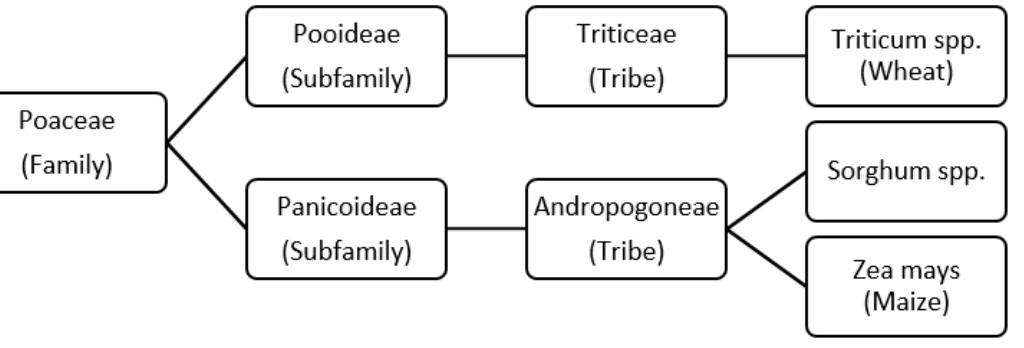
Figure 1. Family tree of sorghum. Modified according to Taylor [12].